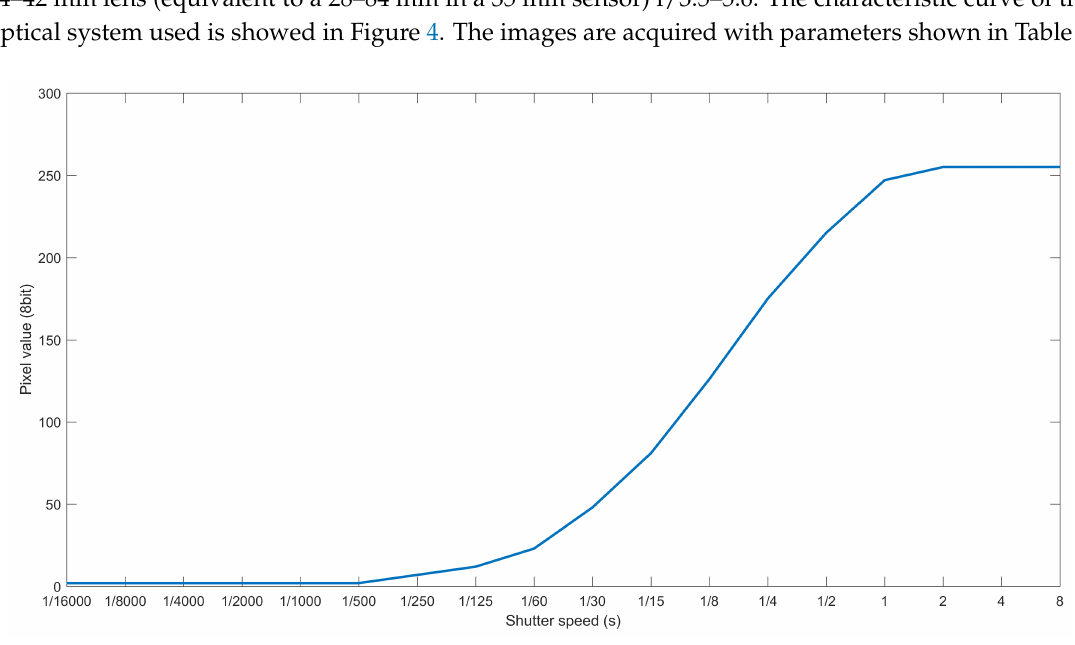
Figure 4. Characteristic curve of camera used (Lumix G7). To construct it we have photographed a white wall keeping an aperture of f8 and varying exposure times from about 1/1,6000 to 8 s. We have then obtained the intensity for each photo, plotted obtained values on the Y -axis, and time on X